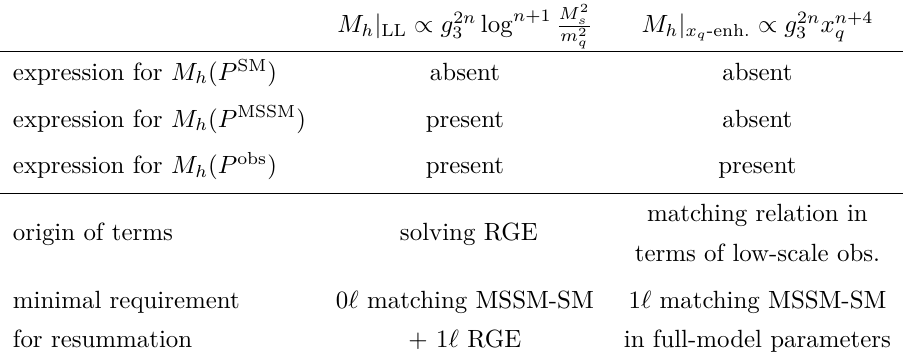
Table 1 . Comparison of leading logarithms and leading x q enhanced terms in QCD contributions to the Higgs pole mass. Depending on the set of variables by which the Higgs pole mass is expressed, logarithmic and/or parametric contributions are present/absent in the analytical relation. The sets P SM , P MSSM and P obs are SM parameters (which in an EFT/RGE calculation are determined via matching to the full theory), MSSM parameters and input parameters,